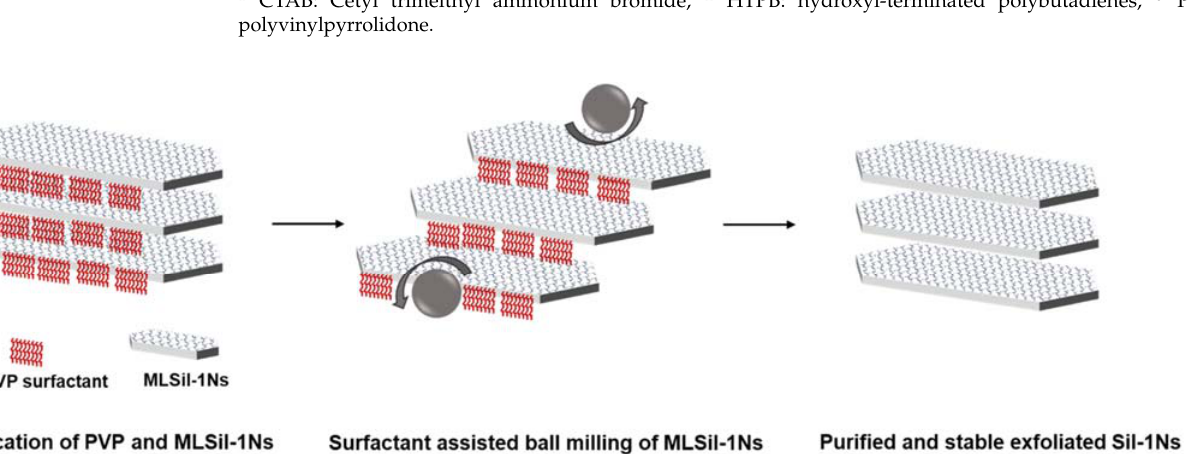
Figure 7. Schematic diagram for the synthesis of MLSil ‐ 1Ns, exfoliation and purification of nanosheets.